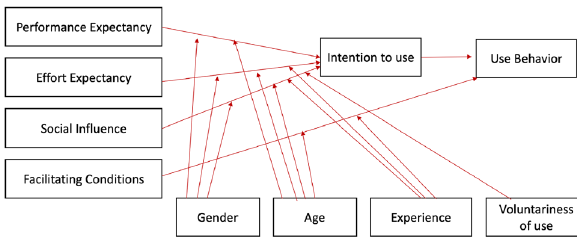
Figure 3: The UTAUT – uni fi ed theory of acceptance and use of